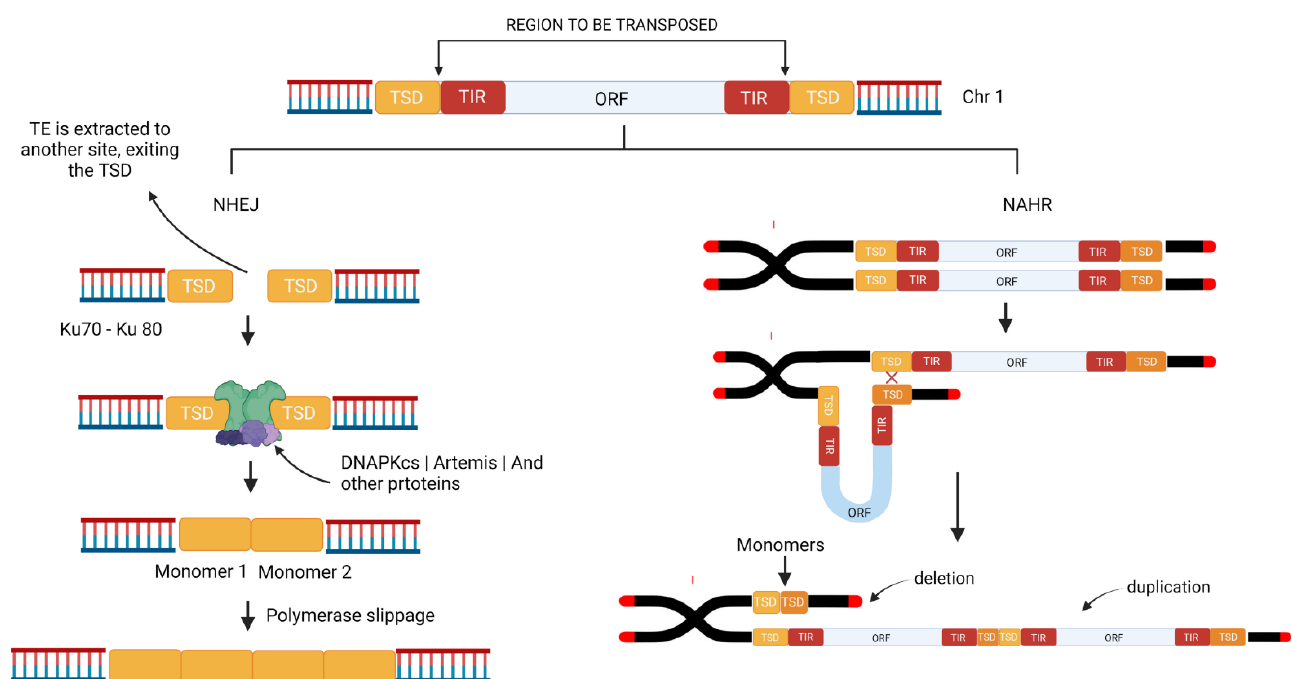
Figure 3. Schematic diagram showing how the Non-Homologous End-Joining (NHEJ) and Non- Allelic Homologous Recombination (NAHR) DNA repair mechanisms contribute to the expansion of tandem repeats from a Transposable Element. TSD (Target Site Duplication); TIR (Terminal Inverted Repeats); ORF (Open Reading Frame). (Source: Authors/created in Biorender.com, accessed on 05/09/2022).